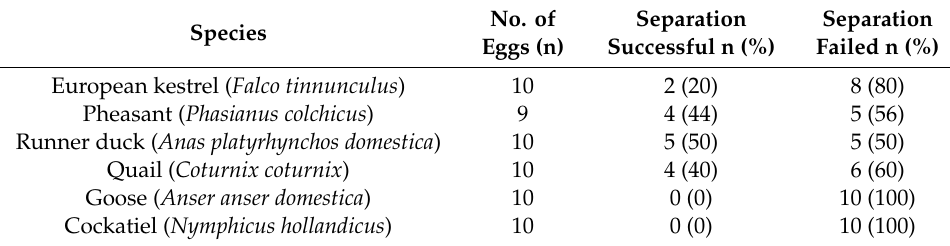
Table 4. Success of IPVM isolation in eggs of other avian species. Species